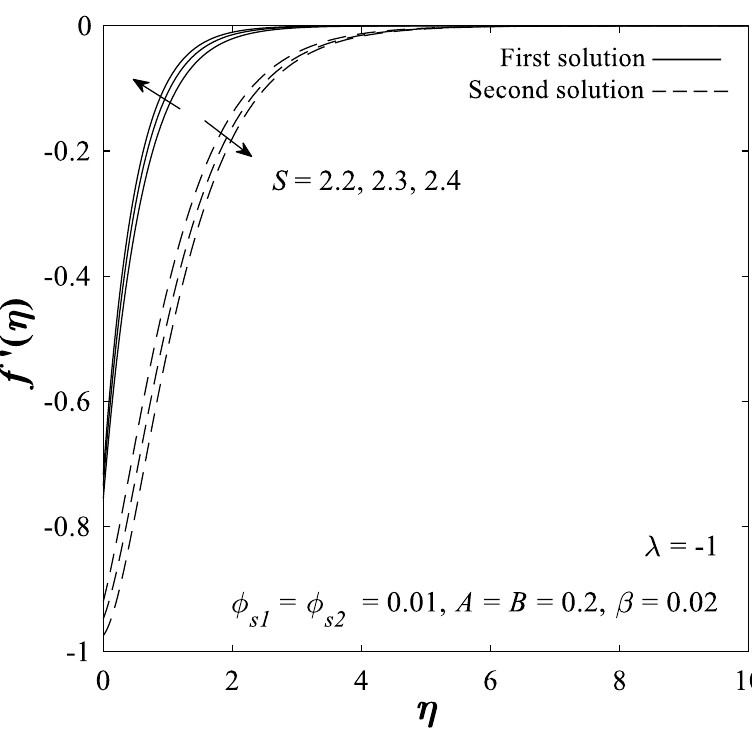
Figure 11. Temperature profile θ ( η ) for varied A .